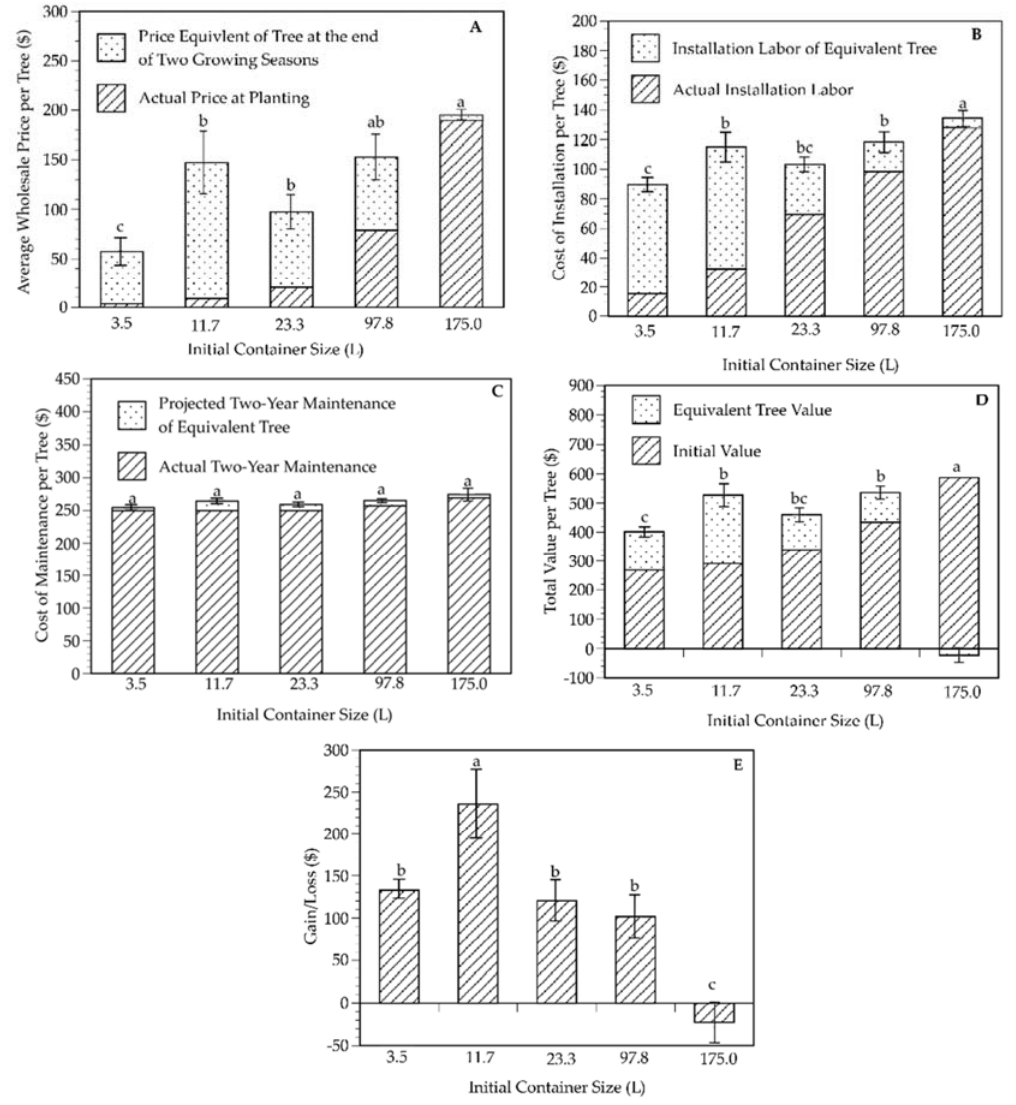
Figure 7. Mean (±standard error) wholesale cost ( A ), installation ( B ), maintenance cost ( C ), value ( D